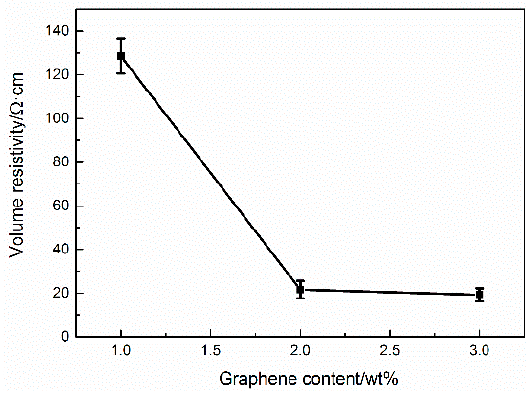
Figure 7. The relationship between volume resistivity and graphene content of the composites (Error bars are standard deviatiion).